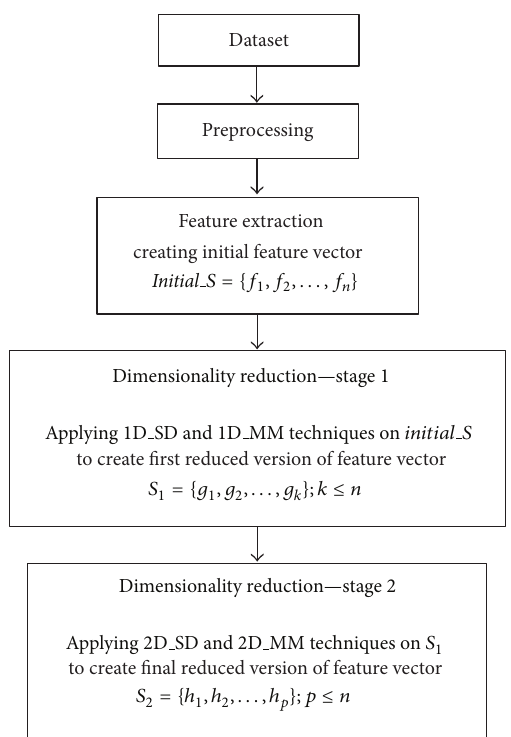
Figure 1: The 2-stage proposed model for dimensionality reduction (feature